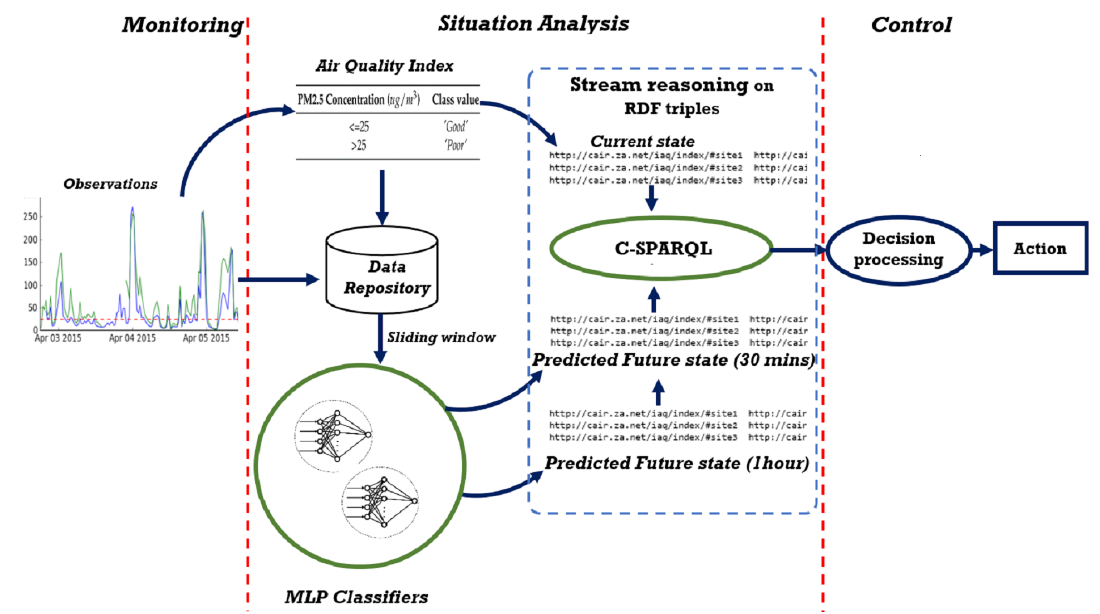
Figure 7. Integration of predictive modules into the PPMC